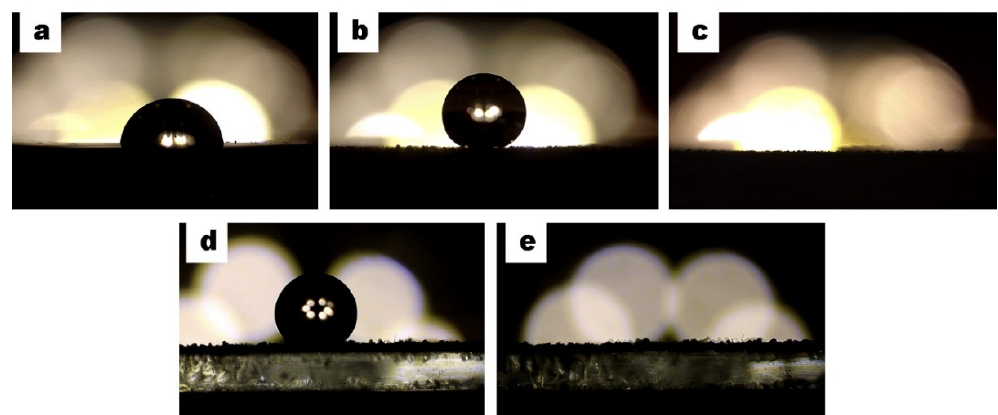
Figure 5. Contact angle measurements: ( a ) WCA on the aluminum substrate (93 ± 3°), ( b ) WCA on the superhydrophobic coating (153 ± 1°), ( c ) OCA on the superhydrophobic coating (0°), ( d ) WCA on the MP (136 ± 1°), and ( e ) OCA on the HDPE-MP (0°).